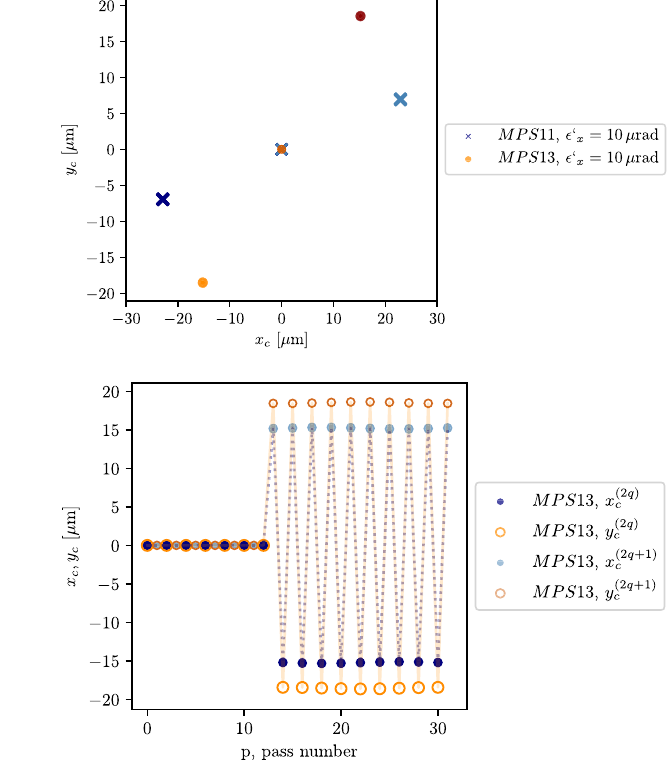
FIG. 25. Simulation of the effect of a du ¼ − 7 . 16 μ rad pointing angle variation of the injection of du x the laser beam in the LBC, where p is the path number and q ∈ ½ 0 ; 16 (cid:4) .